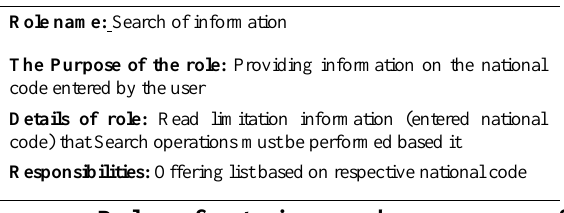
Table 7. The role model for the searching information.